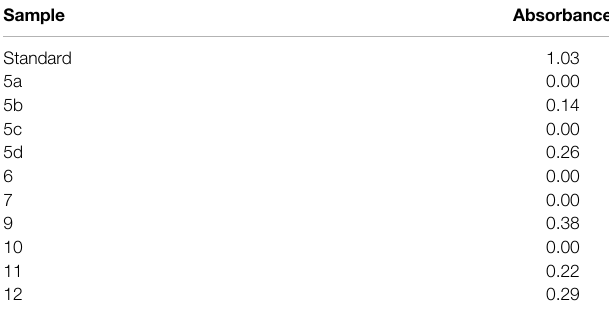
TABLE 1 | Antioxidant activity of compounds 5 – 12 . Sample Standard